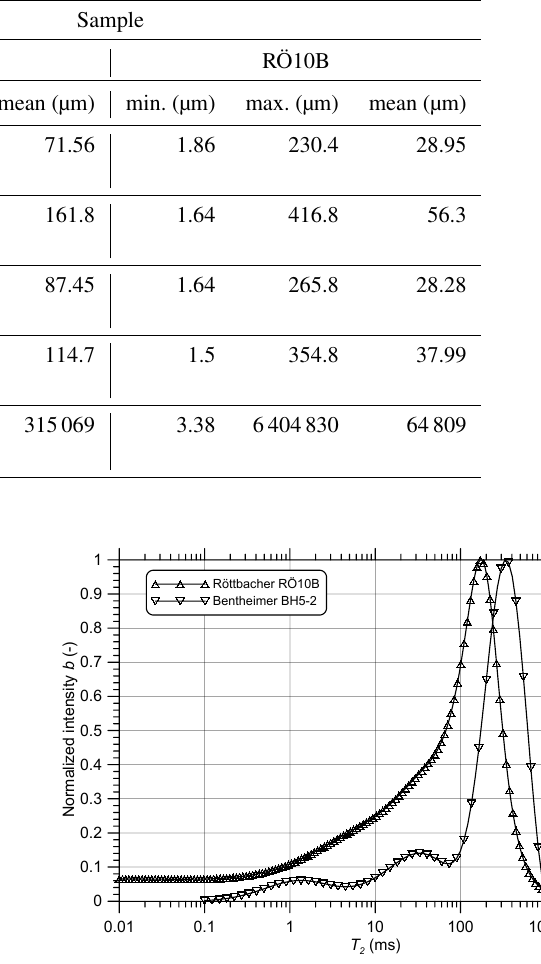
Figure 6. The NMR T 2 relaxation time distributions of samples BH5-2 and